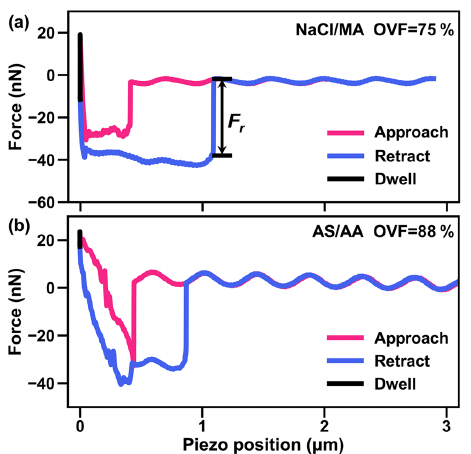
Figure 5. AFM force plots of (a) the NaCl–MA system with 75% OVF and (b) the AS–AA system with 88% OVF. F r is the retention force to break the meniscus using the tip of the AFM probe.